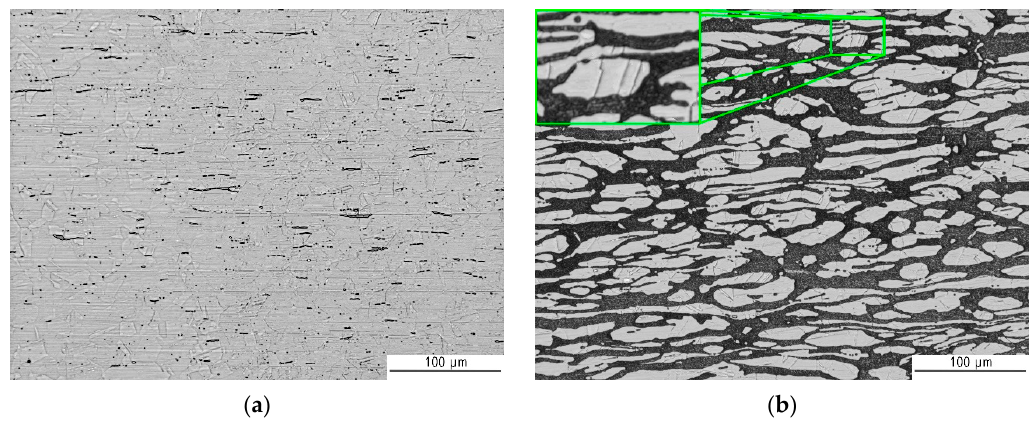
Figure 6. Metallographic structure (light microscope (LM)) of: ( a ) 316L austenitic stainless steel and ( b ) 2304 duplex stainless steel.